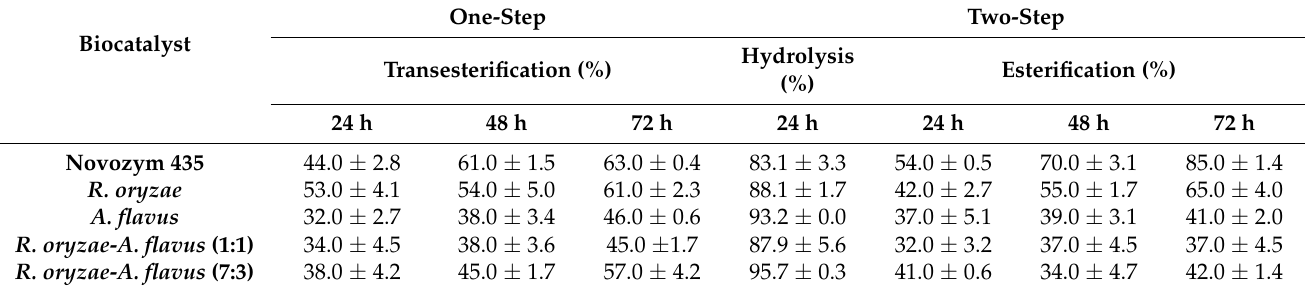
Table 4. Yields (%) of the different reactions performed to prepare monkfish liver oil ethyl esters. (mean ± standard deviations, n =